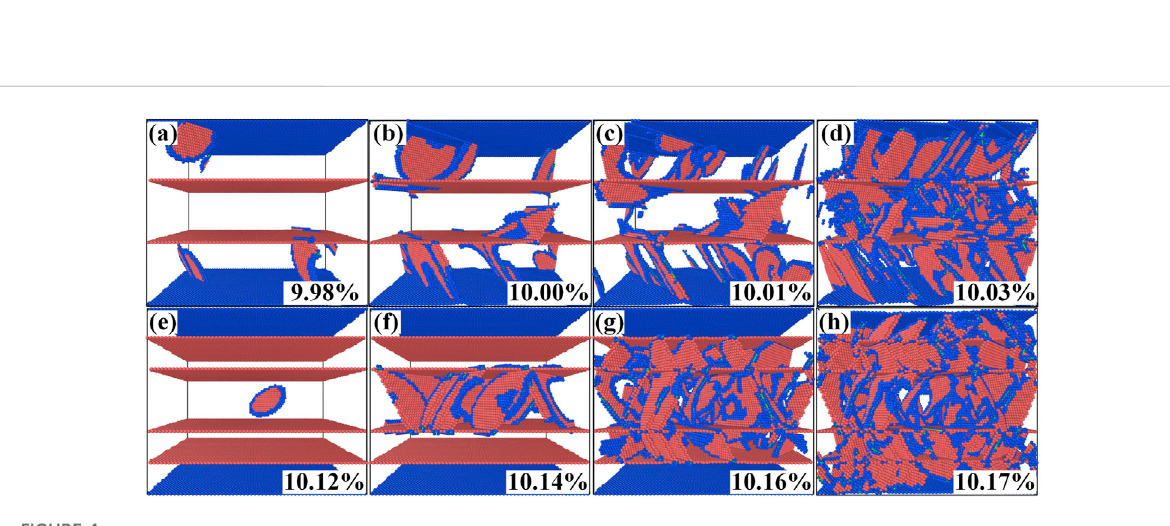
FIGURE 4 The yield process of NT-Cu0 (A – D) and NT-Cu1 (E – H)